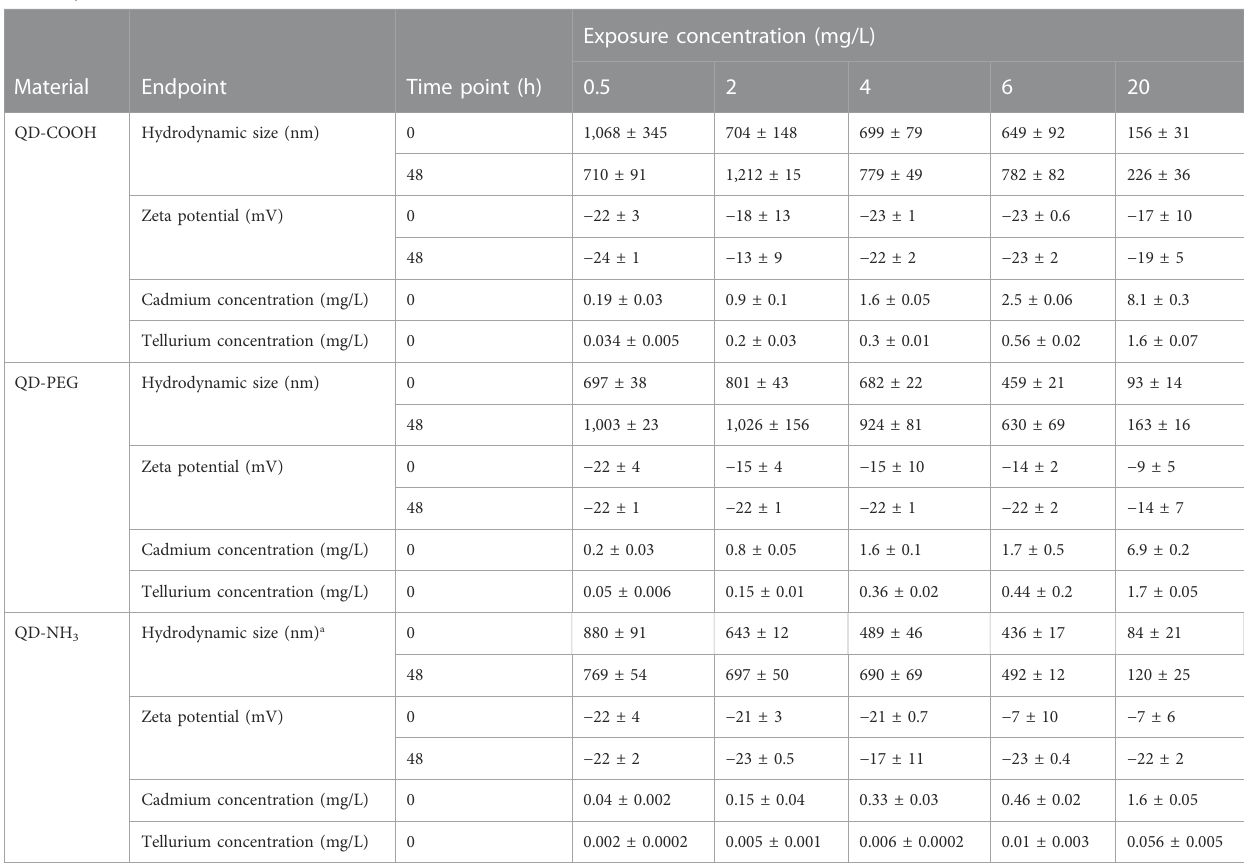
TABLE 2 Hydrodynamic size (nm) distribution, zeta potential (mV) and metal concentrations (mg/L) of CdTe QDs in E3 media (±SD) measured at the North-West